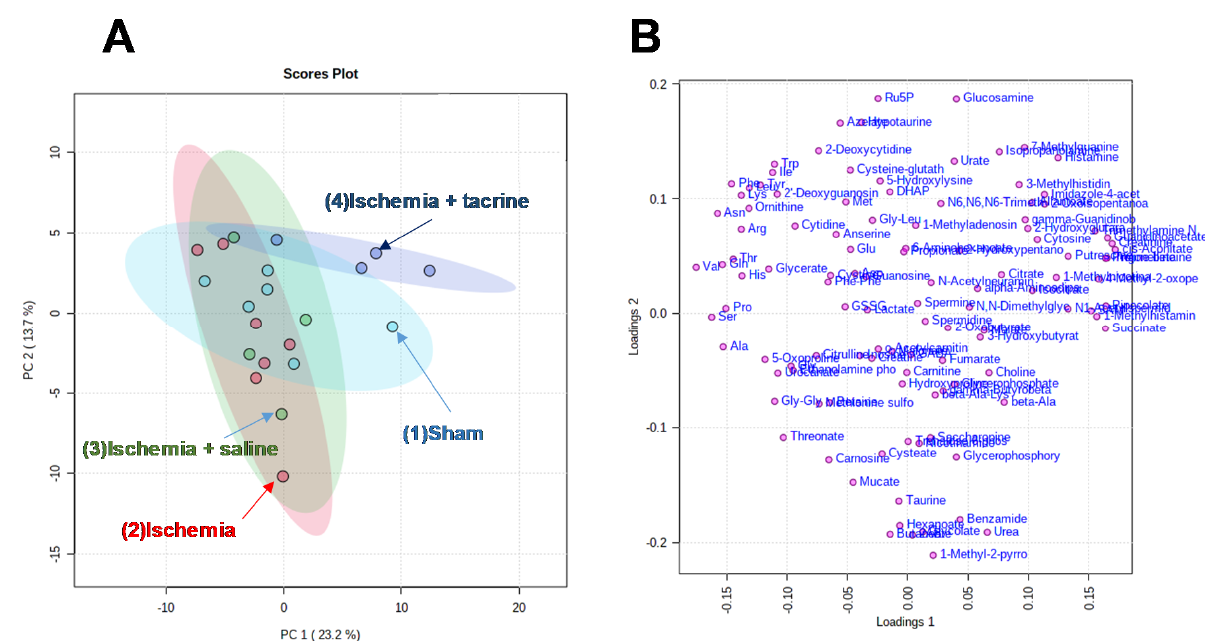
Figure 2. Principal component analysis of salivary metabolite concentrations. ( A ) Score plots and ( B ) loading plots are shown. Metabolite concentrations of each sample were normalized by the pooled sample from the sham group, after which a log transformation was carried out, and an auto-scaling option was used.